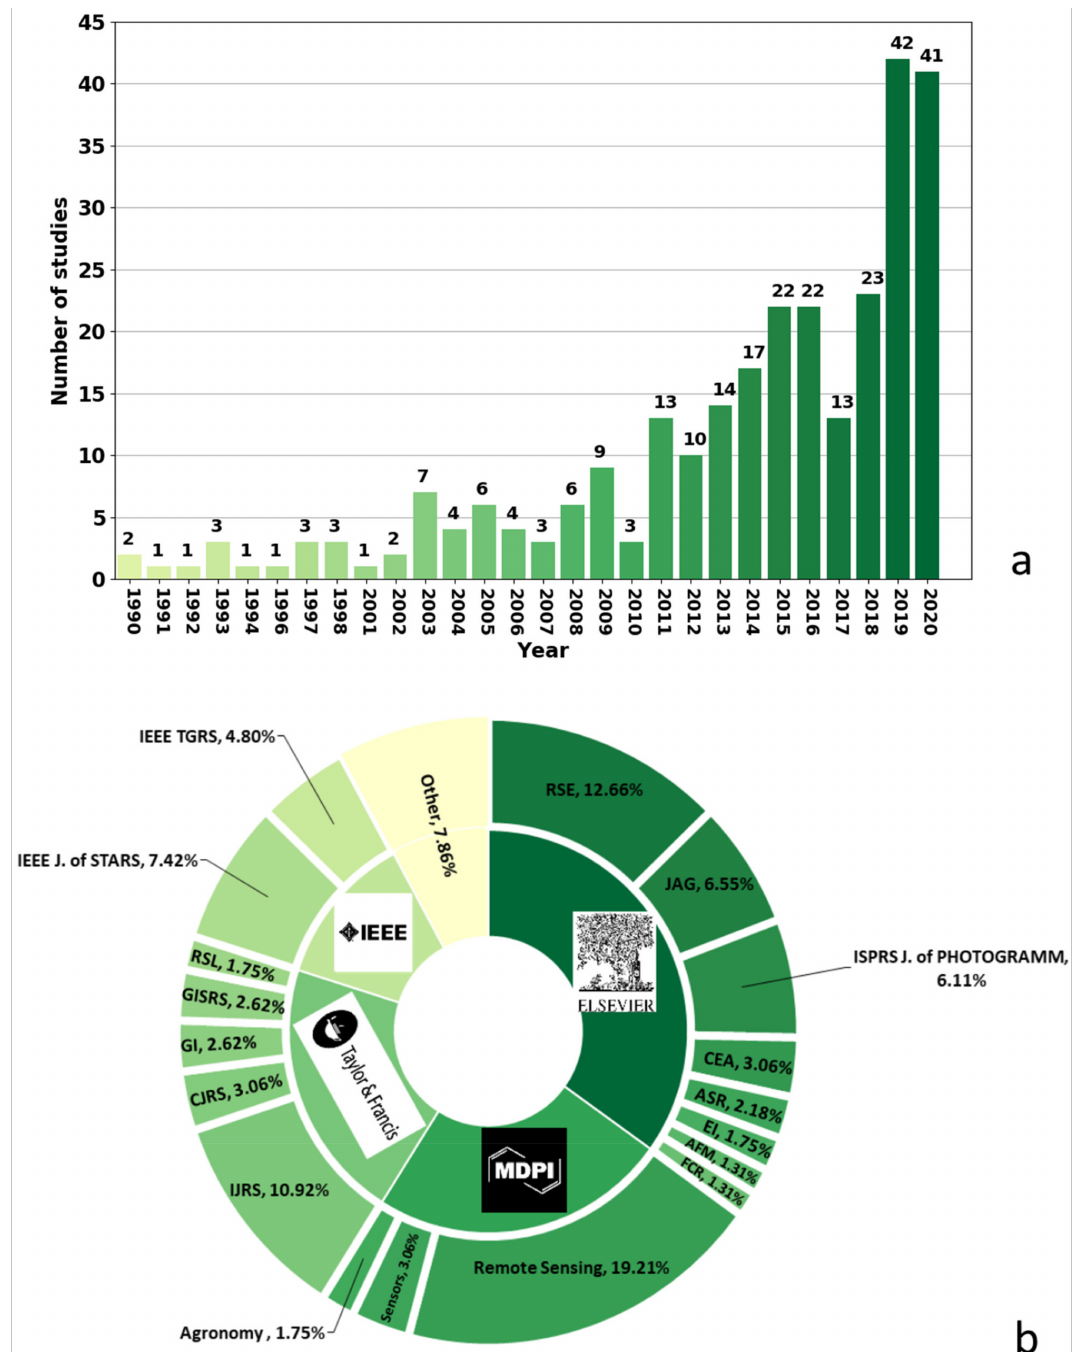
Figure 4. ( a ) The number of studies per year; ( b ) the number of papers published in each journal from 1990 to 2020. The journals with more than two articles were plotted here. In addition, the journals with fewer than five studies are included in the other plot. The journals include the International Journal of Applied Earth Observation and Geoinformation (JAG), ISPRS Journal of Photogrammetry and Remote Sensing (ISPRS J. of PHOTOGRAMM), Computers and Electronics in Agriculture (CEA), Advances in Space Research (ASR), Ecological Indicators (EI), Agricultural and Forest Meteorology (AFM), Field Crops Research (FCR), Canadian Journal of Remote Sensing (CJRS), Geocarto International (GI), GIScience and Remote Sensing (GISRS), Remote Sensing Letters (RSL), IEEE Journal of Selected Topics in Applied Earth Observations and Remote Sensing (IEEE J. of STARS), IEEE Transactions on Geoscience and Remote Sensing (IEEE